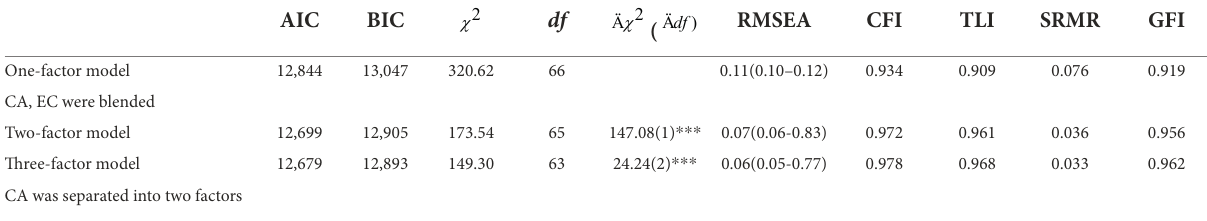
TABLE 7 Comparison of factor